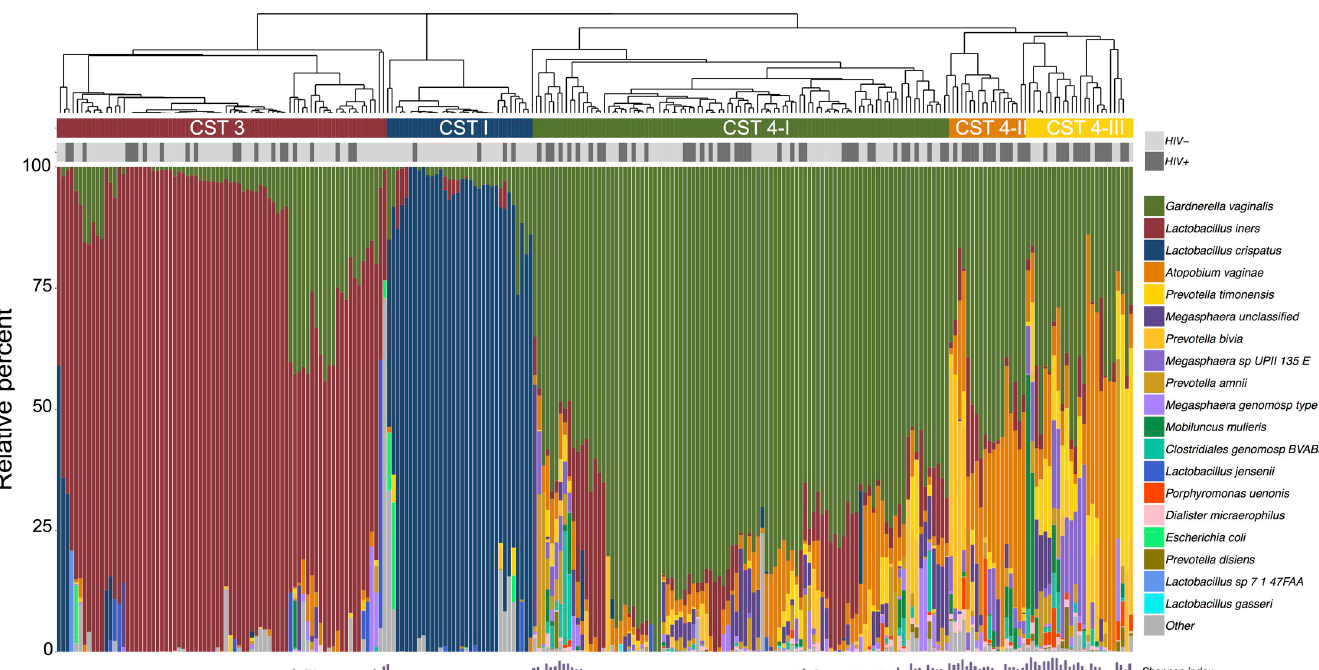
Fig 3. Bacterial diversity plot of major bacterial taxa and identified community states in ZAPPS. Diversity plot demonstrating the relative abundance of the most common bacterial species identified across all specimens (n = 256) and the results of hierarchical clustering into 5 major community state types dominated by: Lactobacillus crispatus (CST I), Lactobacillus iners (CST 3), Gardnerella vaginalis (CST 4-I), Gardnerella vaginalis & Atopobium vaginae (CST 4-II), and mixed anaerobes (CST 4-III). CST, community state type.